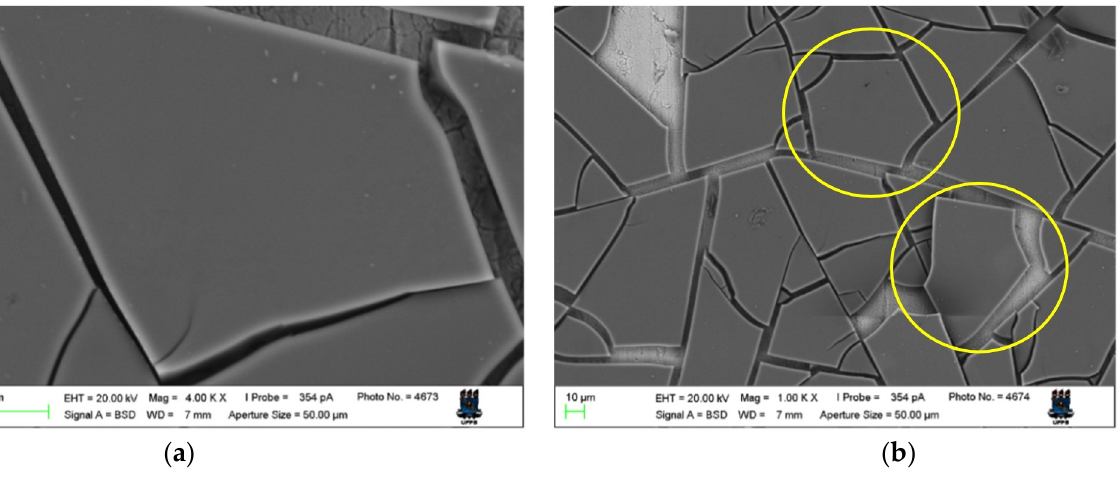
Figure 9. Scanning electron microscopy for samples with DC (detergent cleaning) treatment and 1 min deposition time. Magnifications: ( a ) 4000×; ( b ) 1000×; ( b ) shows grains detachment.